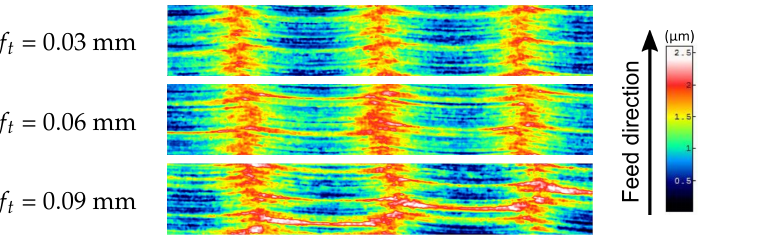
Figure 9. Surface parts with dimensions of 0.2 mm × 1.2 mm from the measured surface topographies of samples made of titanium alloy Ti Gr 5 after milling with a cutting width of b r = 0.4 mm and different values of feed f t .